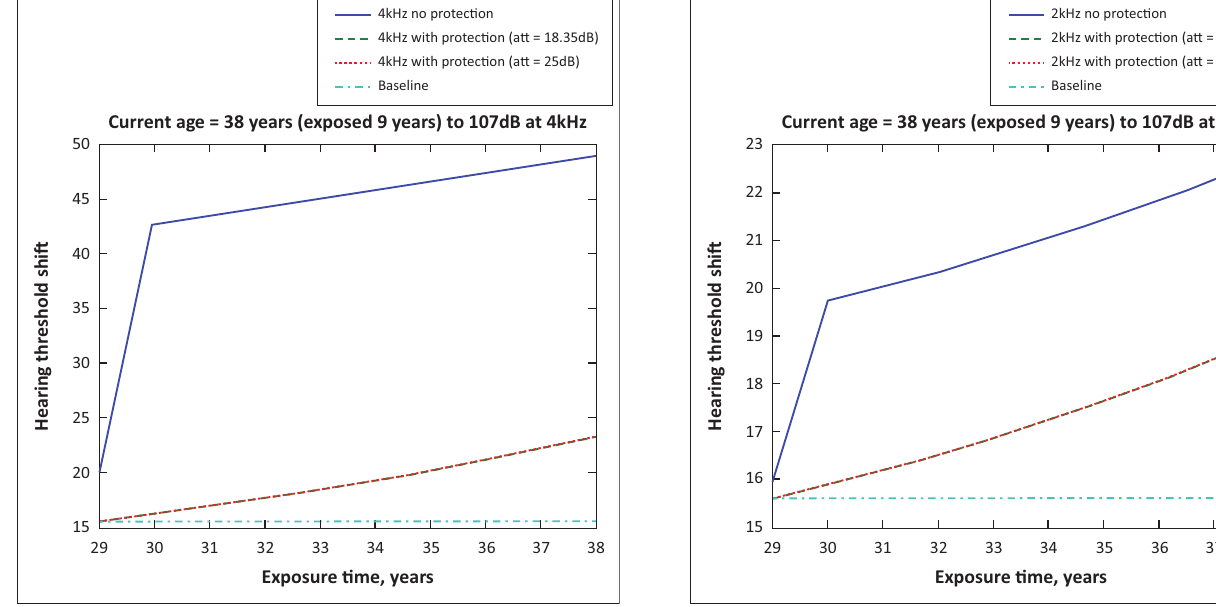
Source : Figure created using data from Moroe, N.F. (2018). Occupational noise-induced hearing loss in South African large scale mines: From policy formulation to implementation and monitoring. Doctoral thesis. Johannesburg: University of the Witwatersrand. FIGURE 9: Thirty-eight years old at 2000 Hz with exposure levels of 107 dB.